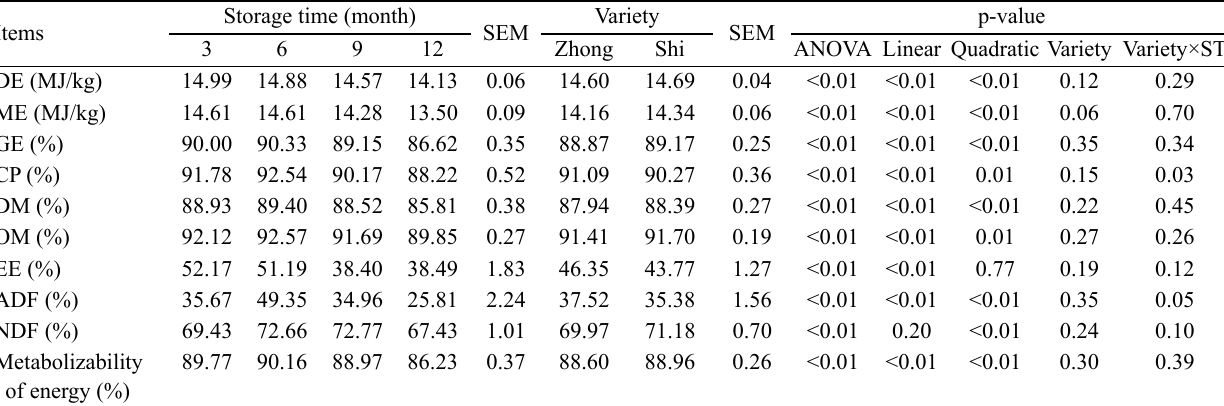
Table 5. Digestibility of chemical constituents of wheat after different storage times when fed to finishing pigs (as-fed basis) Items SEM